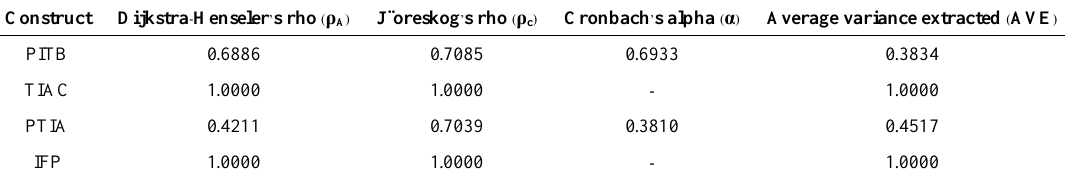
Table 1. The result of validity and reliability measurement